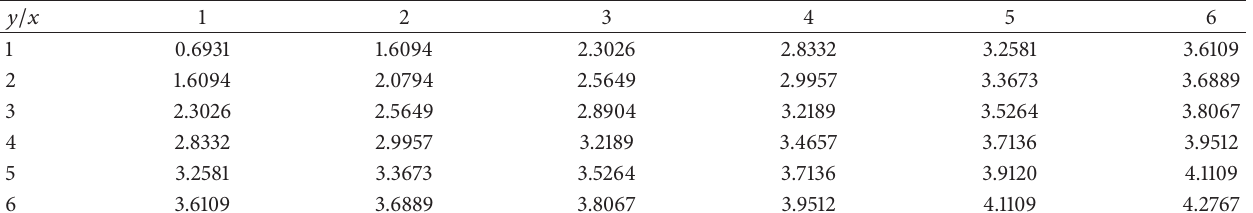
Table 6: A 3D monotone data